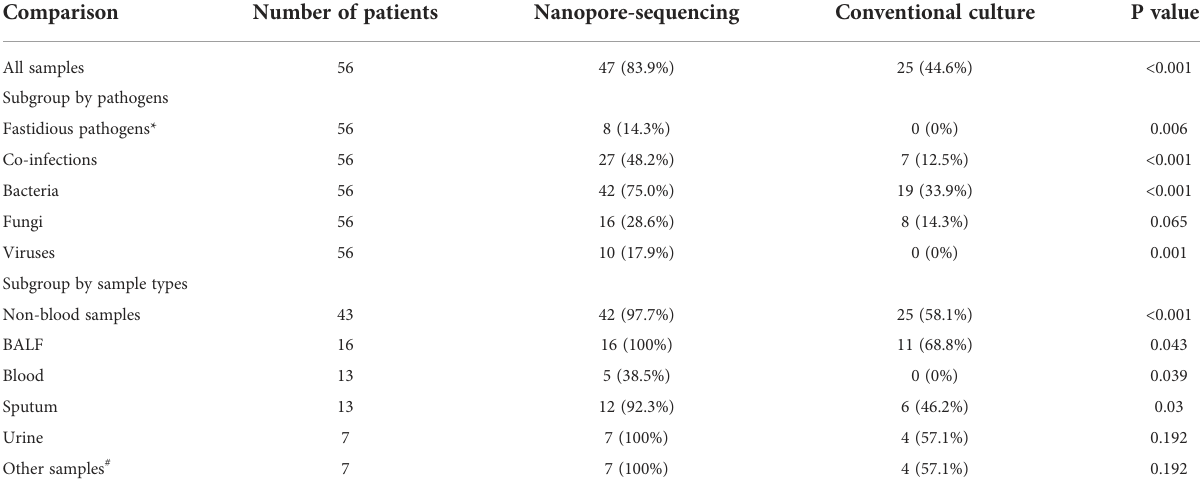
TABLE 3 Comparison of the performance in detecting pathogens between nanopore amplicon sequencing and conventional